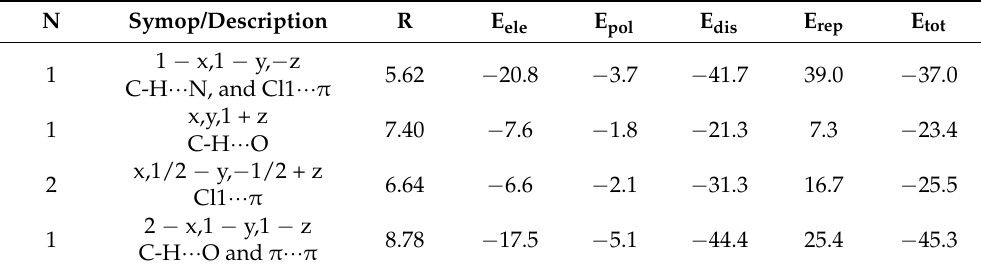
Table 6. Selected CrystalExplorer CE-B3LYP interaction energies (kJ/mol) for 3 . N is the number of molecules with a molecular centroid-to-centroid distance R (Å). Electron density was calculated using B3LYP/6-31G(d,p) model energies. Symop is the symmetry operation.